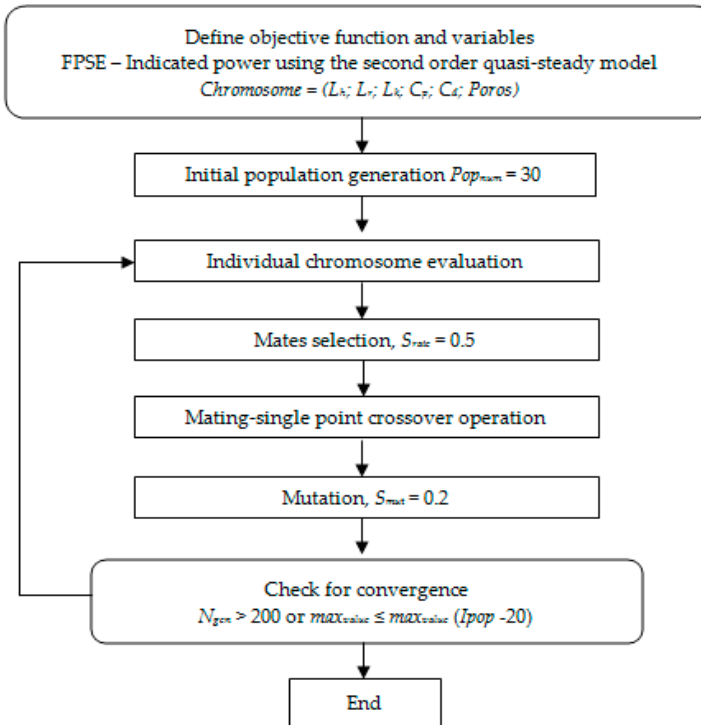
Figure 3. Flow chart of the genetic algorithm procedure.